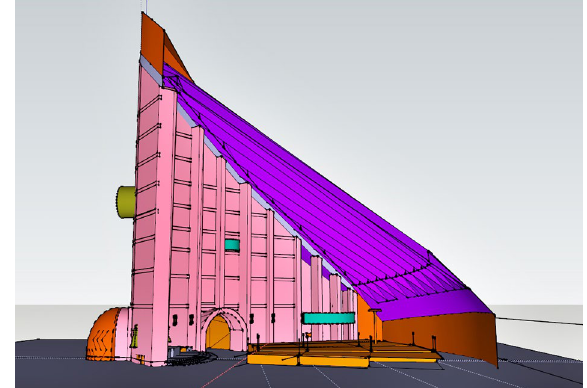
Figure 7. Cross-section with a perspective – the colours represent individual